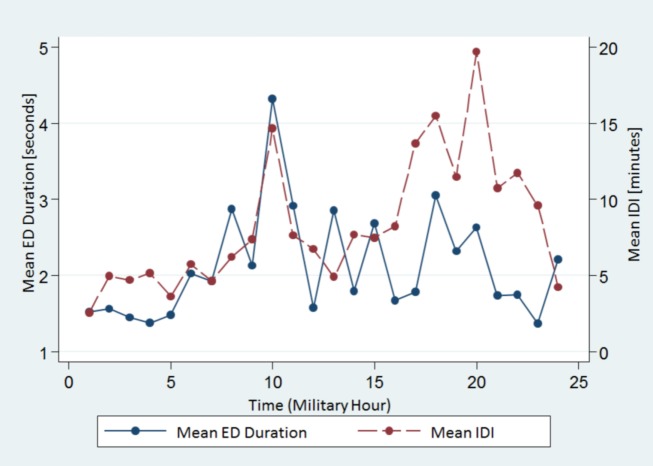
The spread of the mean ED duration and the IDI from all subjects across the 24-h time scale. Note both variables show similar undulations. ED, epileptiform discharge, IDI, interdischarge interval.